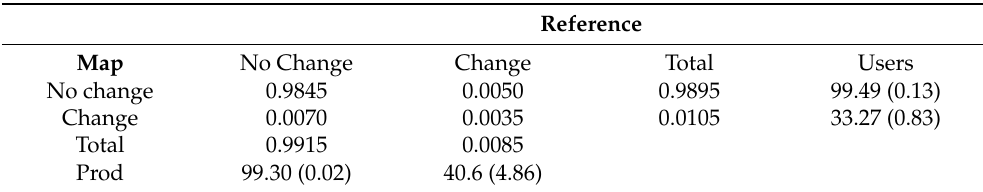
Table 9. Error matrix for the binary change and no-change classification for 2000–2010. The values in parentheses are standard deviations. OA = 98.79% ± 0.14%.